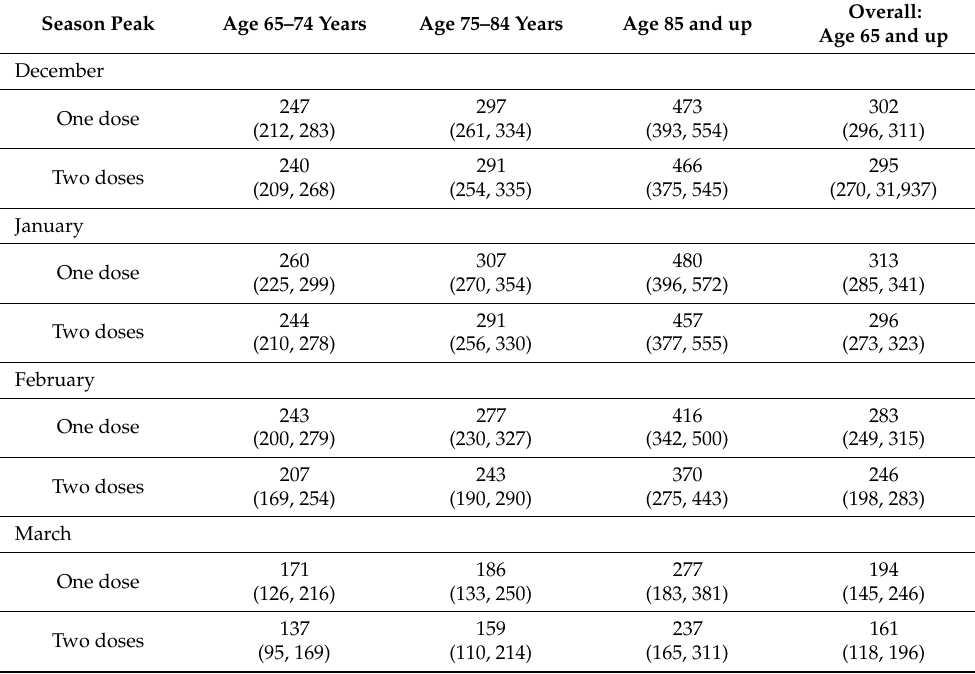
Table 3. Influenza hospitalizations per 100,000 population by peak month and by age group in age 65 and up